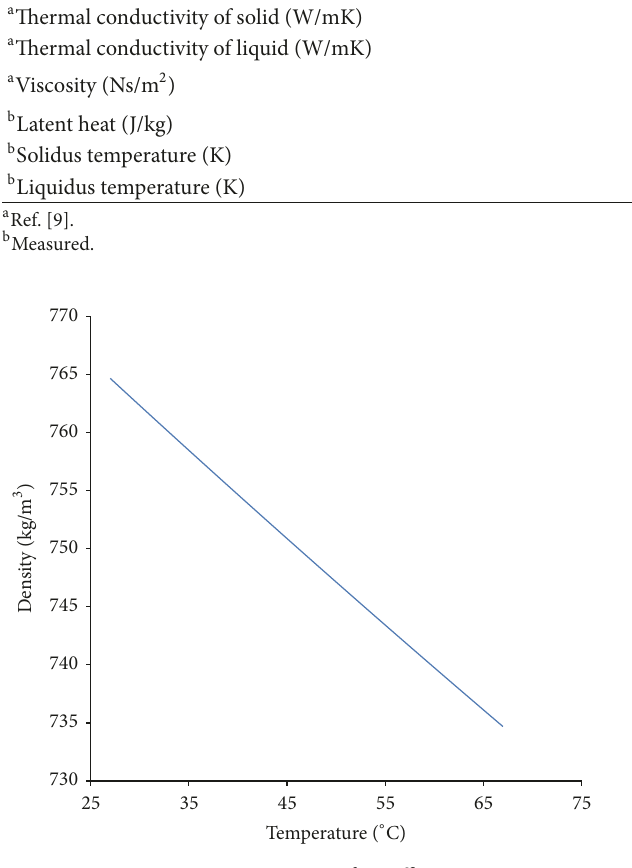
Figure 4: Density of paraffin.